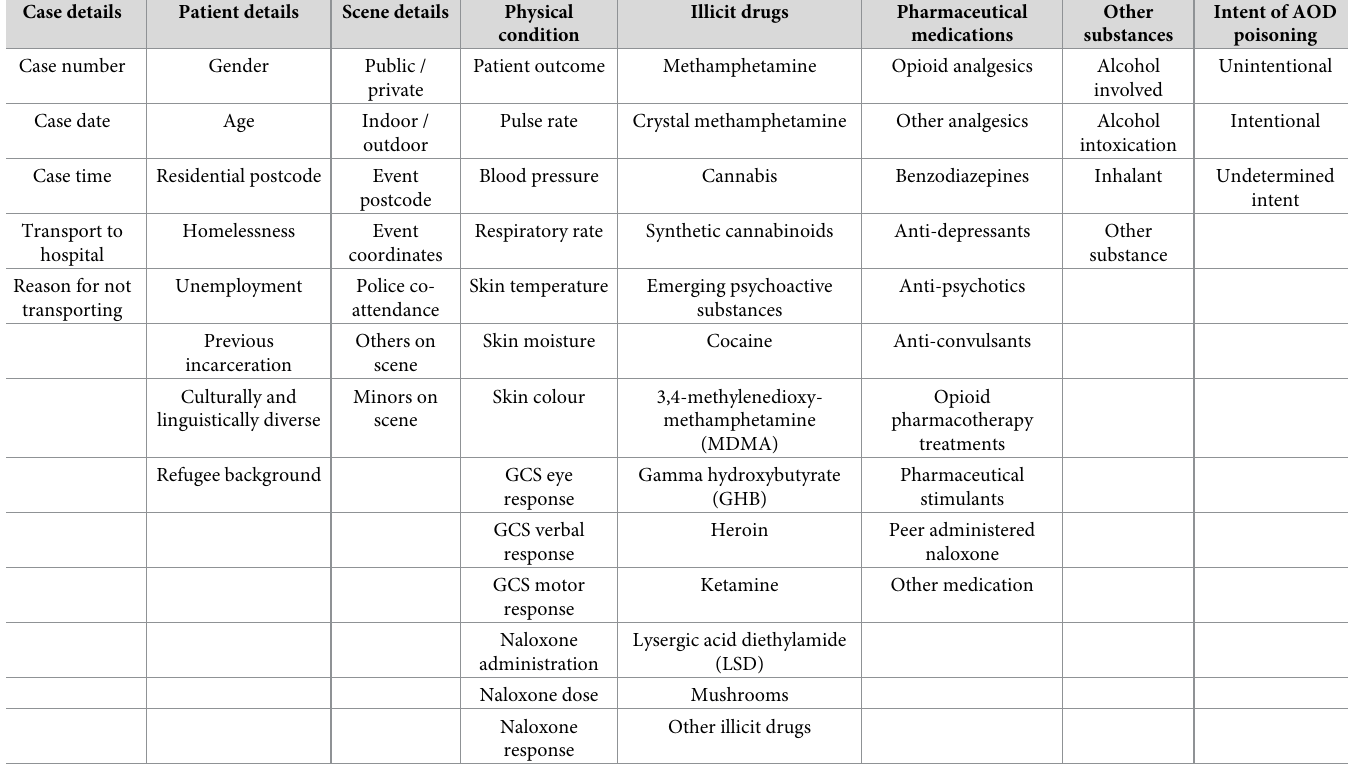
Table 2. National Ambulance Surveillance System output variables, including scene patient and clincal details, alcohol, individual illicit drugs and pharmaceutical medication drug classes �